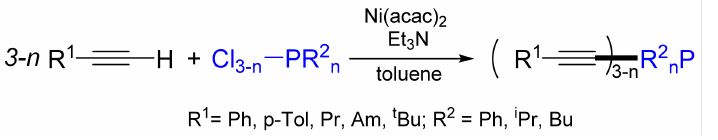
Figure 3. General scheme for a nickel-catalyzed cross-coupling reaction with terminal alkynes.